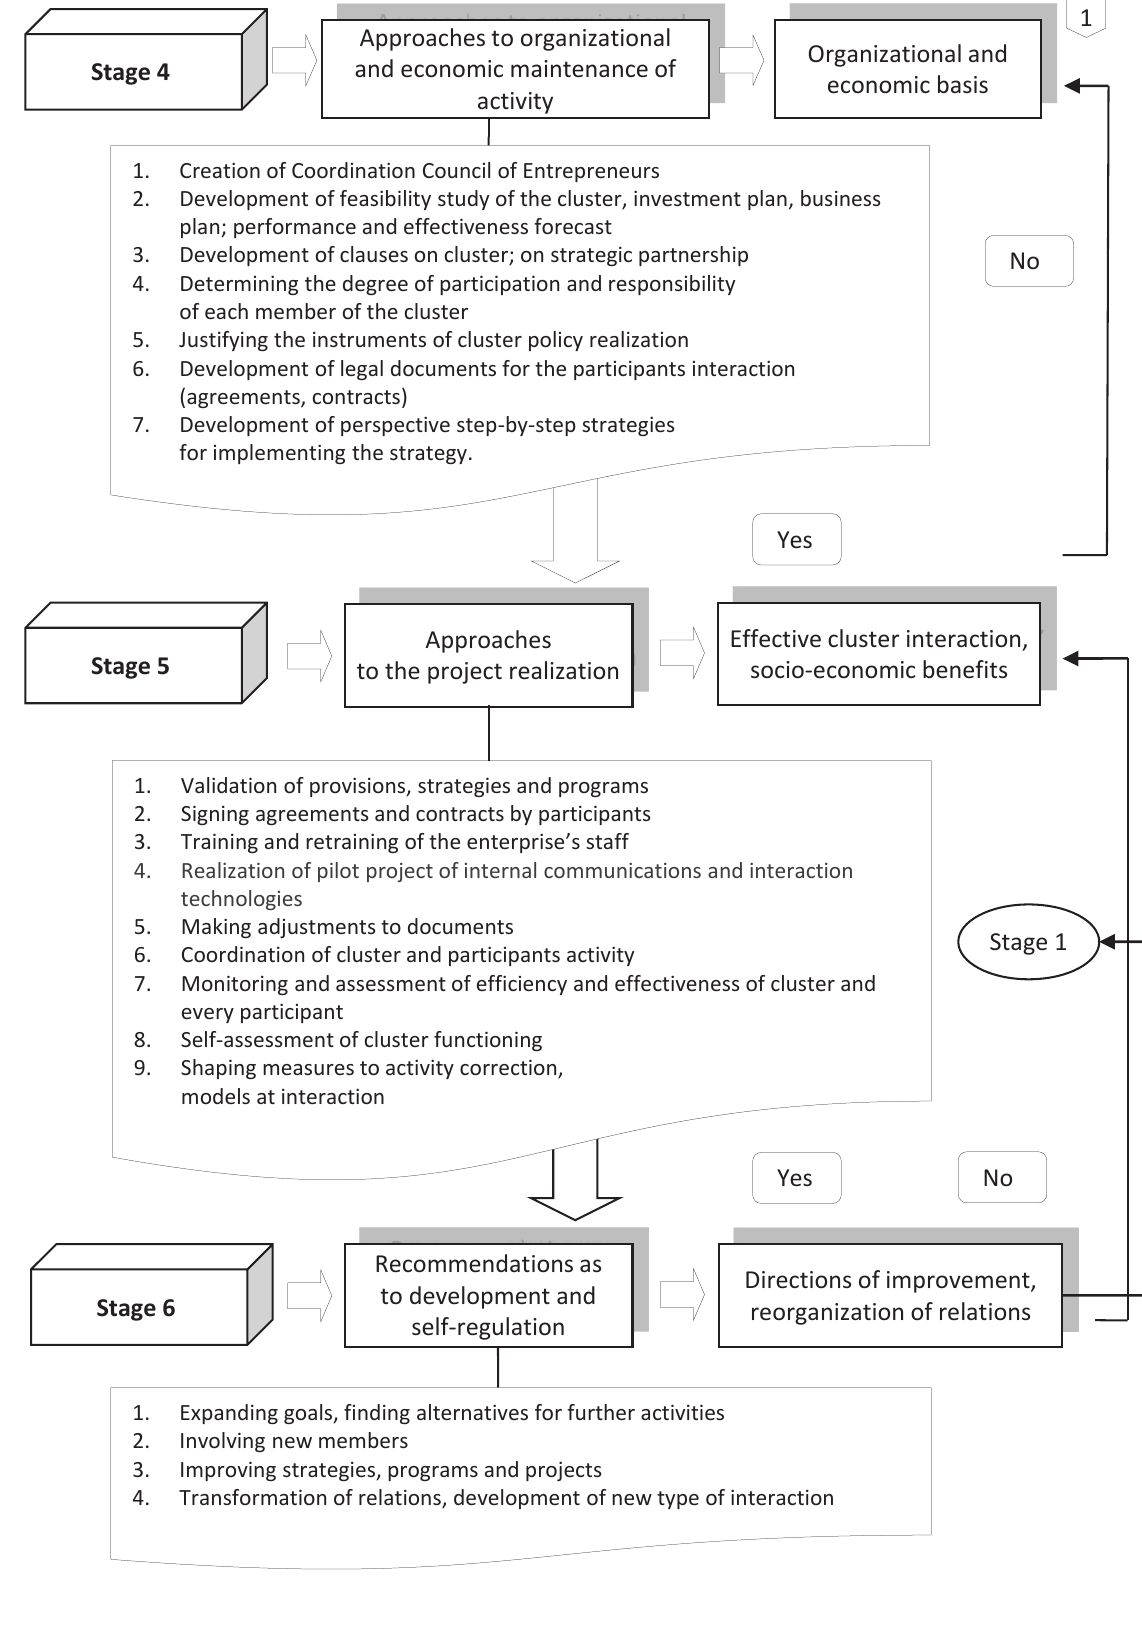
Figure 1 (end). Methodology of economic entities’ cluster